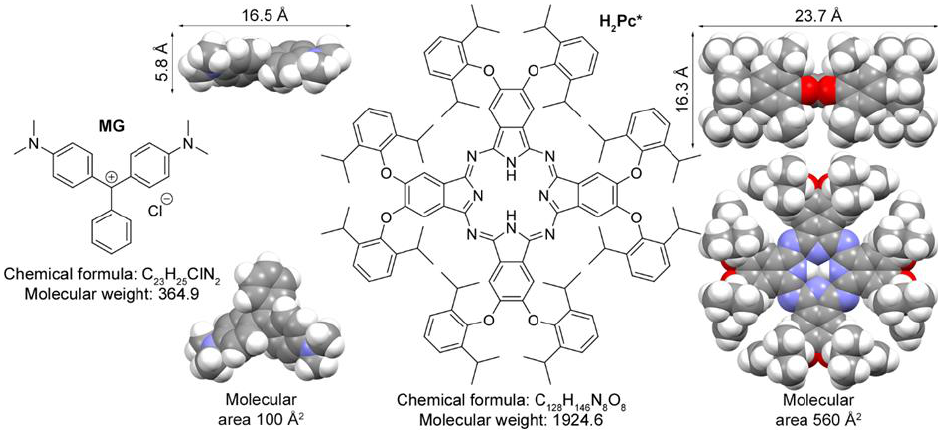
Figure 2. Compounds studied in the present work – malachite green dye, MG ; and octa (2,6-diiso- propylphenoxy) phthalocyanine, H 2 Pc*. Molecular sizes are based on space-filling models obtained by geometrical optimization at the BP86/def2-SVP level of theory (only triphenylmethyl cation was optimized in the case of MG).